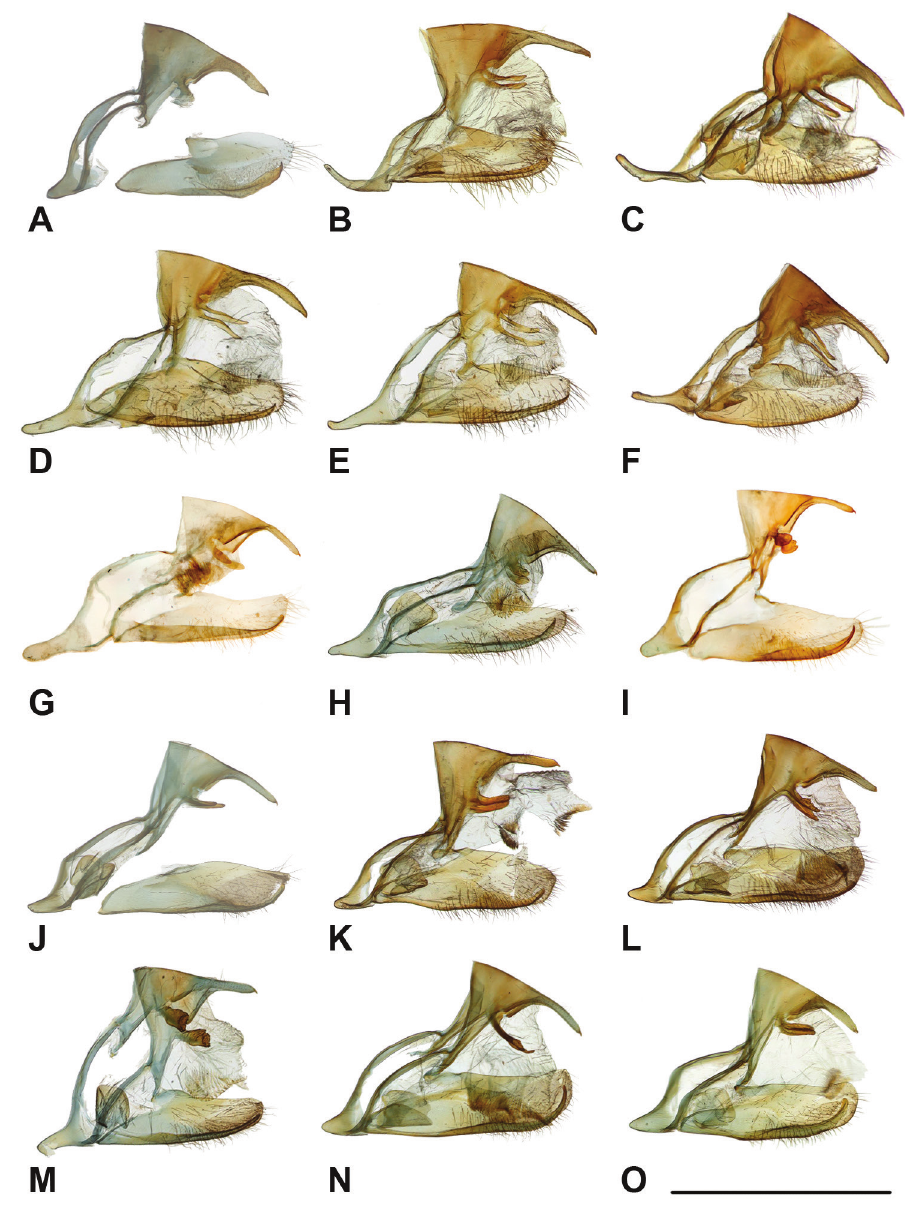
Figure 22. A bammakoo bammakoo NHM Central Africa B paradoxa NHM Indonesia: Papua,